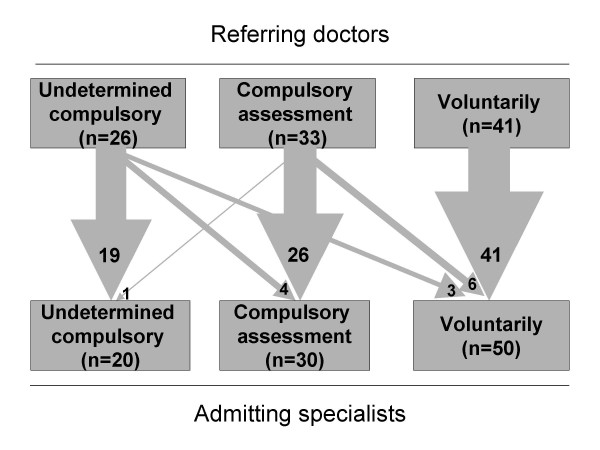
Legal basis of admissions. The legal basis of the acute psychiatric admissions from Tromsø Casualty Clinic in 2001 according to referring doctor and admitting specialist (psychiatrist or clinical psychologist) at University Hospital of Northern Norway. Numbers indicate number of patients.